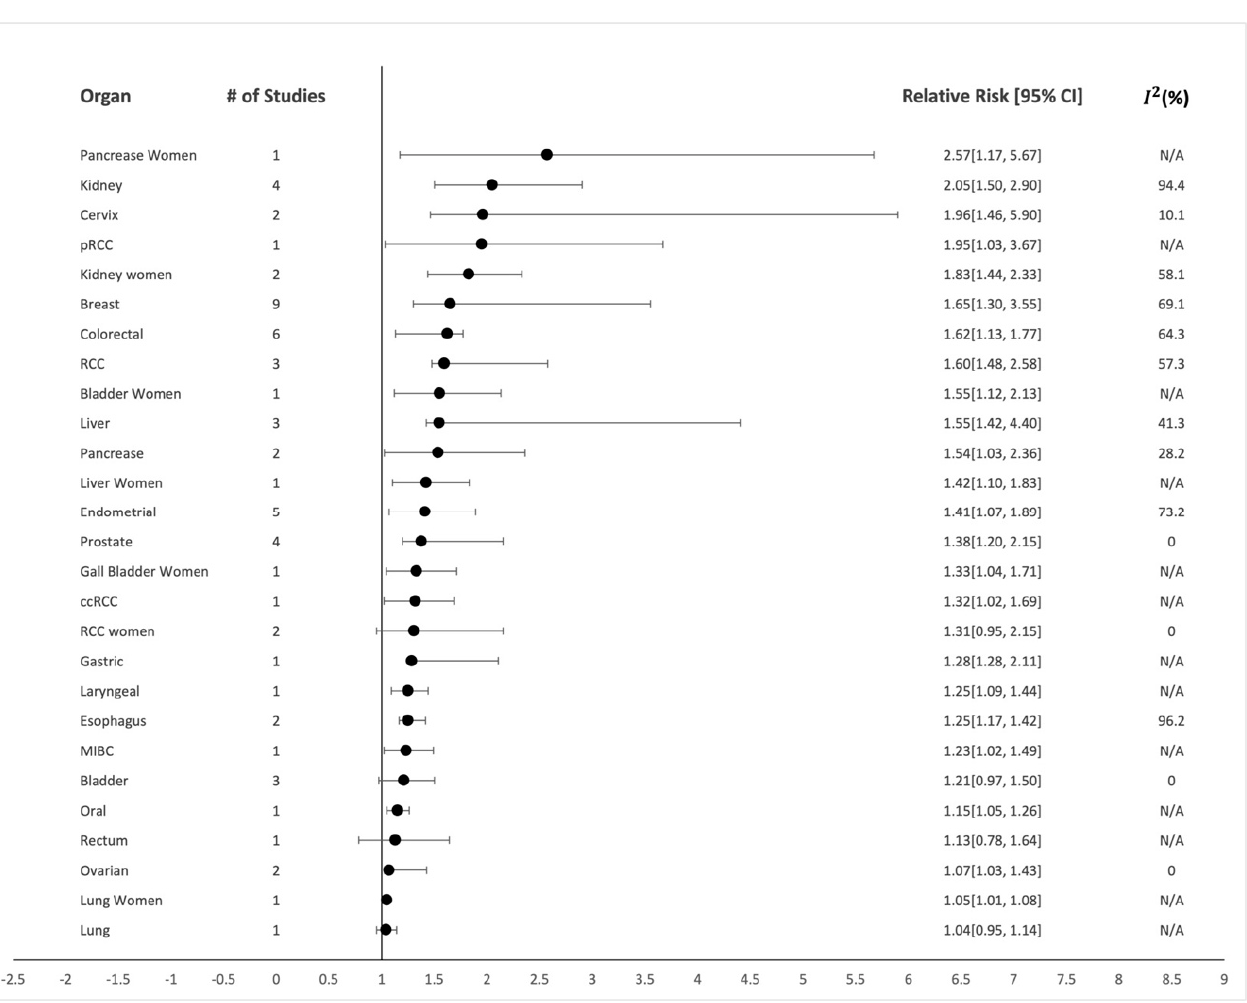
Figure 3. Dose-dependent SBP summary of the relative risks and 95% confidence intervals for each individual organ − specific cancer site.